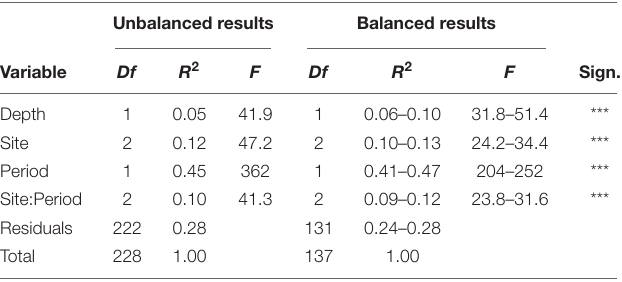
TABLE 2 | PERMANOVA results shown from the full (unbalanced) dataset as well as ranges from 1,000 under-sampled, balanced